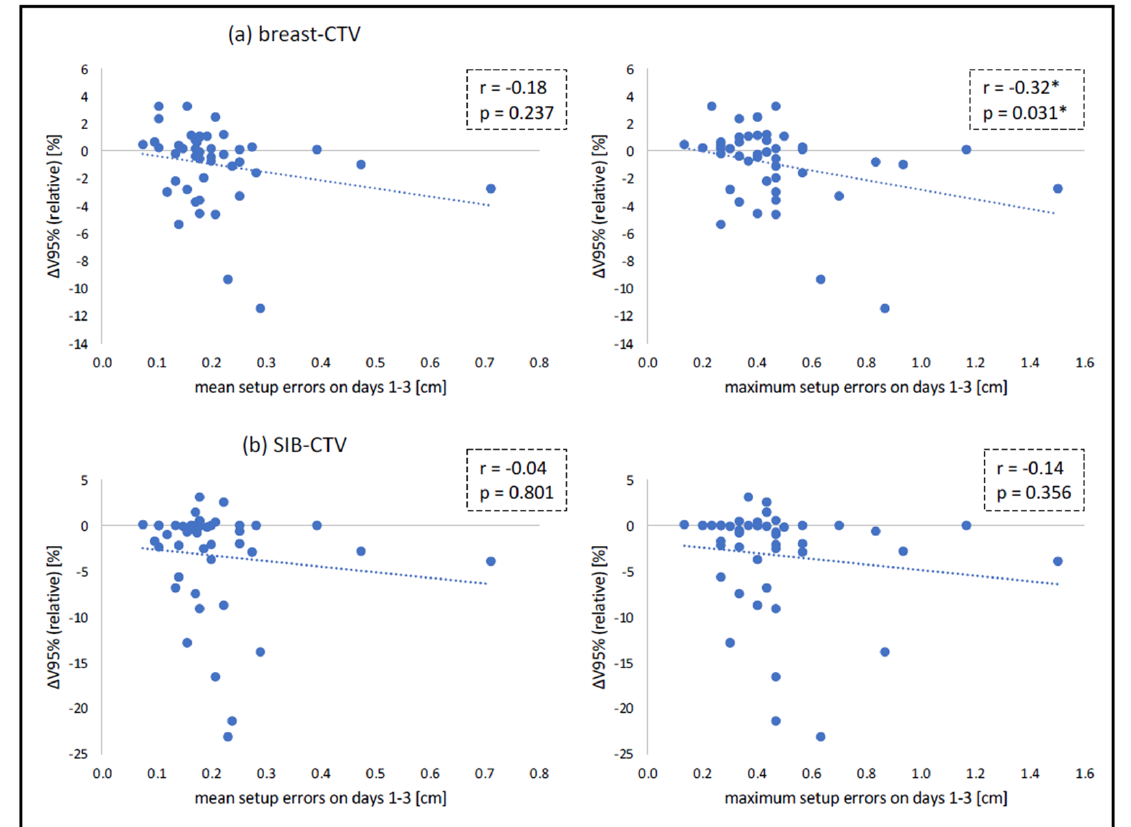
Table 1. Correlation analysis for CTV coverage and setup errors on days 1–3.